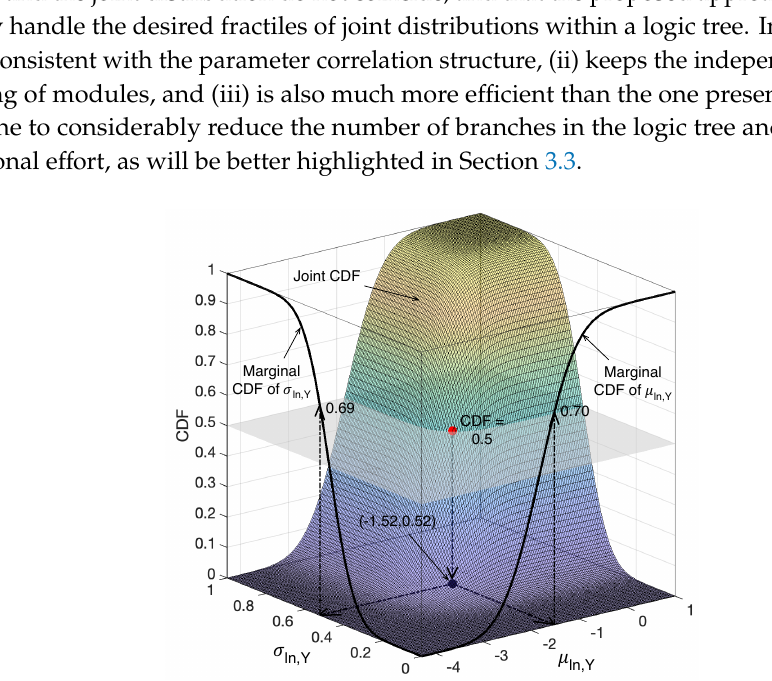
Figure 3. Example showing the derivation of the fractiles of the two fragility parameters corresponding to the 50% fractile (black dot) of the joint distribution, according to the approach proposed